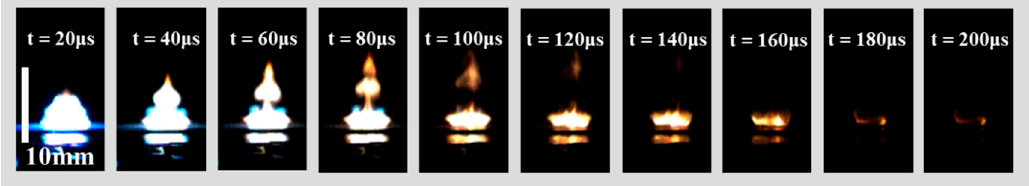
Figure 6. The high-speed camera photos of the ignition process of the CoFe 2 O 4 / Al NWs nanothermite film (Al = 400 nm).